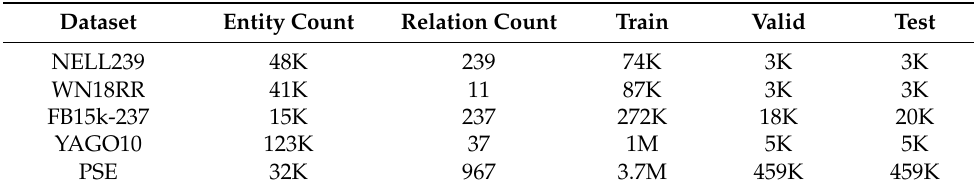
Table 1. Statistics of entities, relations, and triples count per split of the benchmarking datasets which we use in this